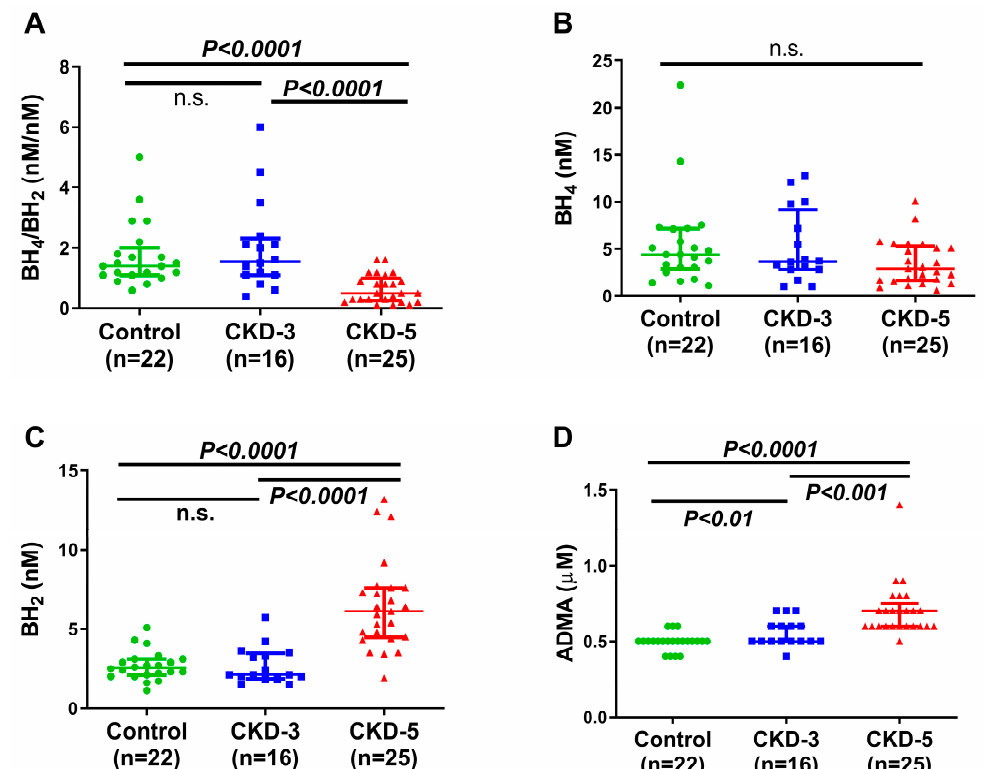
Figure 2. Plasma concentration of BH 4 , BH 2 and ADMA. BH 4 /BH 2 ratio ( A ), BH 4 ( B ), BH 2 ( C ) and ADMA ( D ) between control (n = 22), CKD-3 (n = 16) and CKD-5 (n = 25) groups, respectively. Data are expressed as median (interquartile range); significances were assessed by Mann–Whitney U-test. p < 0.0001 for BH 4 /BH 2 and BH 2 between control vs. CKD-5 and CKD-3 vs. CKD-5; for ADMA, p < 0.0001 between control vs. CKD-5, p < 0.01 between control vs. CKD-3 and p < 0.001 between CKD-3 vs. CKD-5. BH 4 , BH 2 and ADMA were measured using chromatographic separation, and the BH 4 /BH 2 ratio was calculated. BH 4 = tetrahydrobiopterin; BH 2 = dihydrobiopterin; ADMA = asym- metric dimethylarginine; CKD-3 = chronic kidney disease stage 3; CKD-5 = chronic kidney disease stage 5. n.s.: no significance.